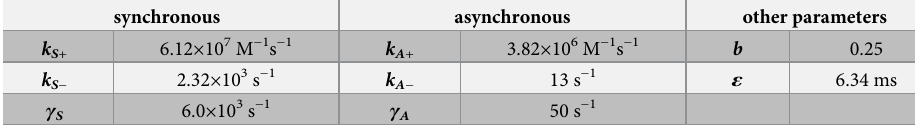
Table 1. SNARE Release State Transition Parameters.